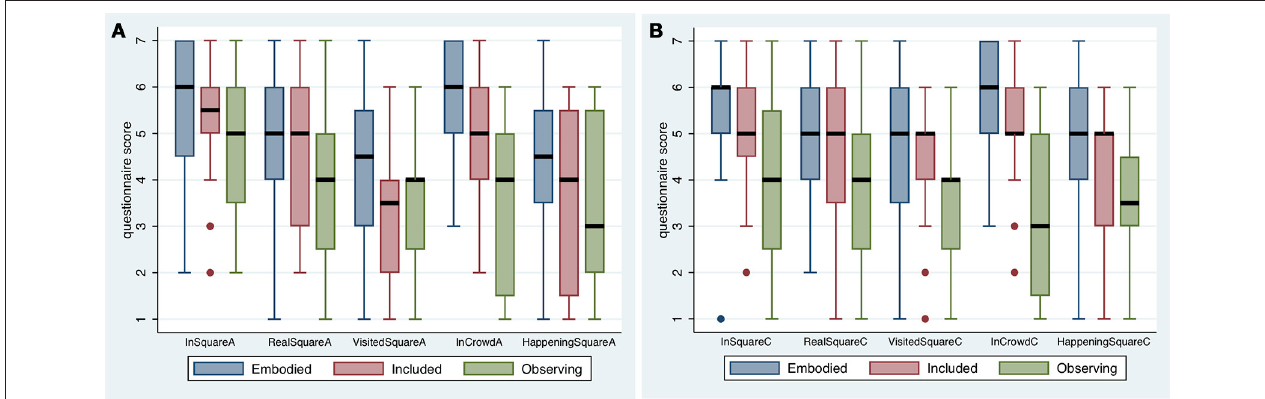
FIGURE 3 | Box plots results on the questions relating to presence in periods (A , B) . The thick horizontal lines are the medians, and the boxes the interquartile ranges (IQR). The whiskers extend from max(min value, 25%tile- − 1.5*IQR) to min(max value, 75%tile + 1.5*IQR).